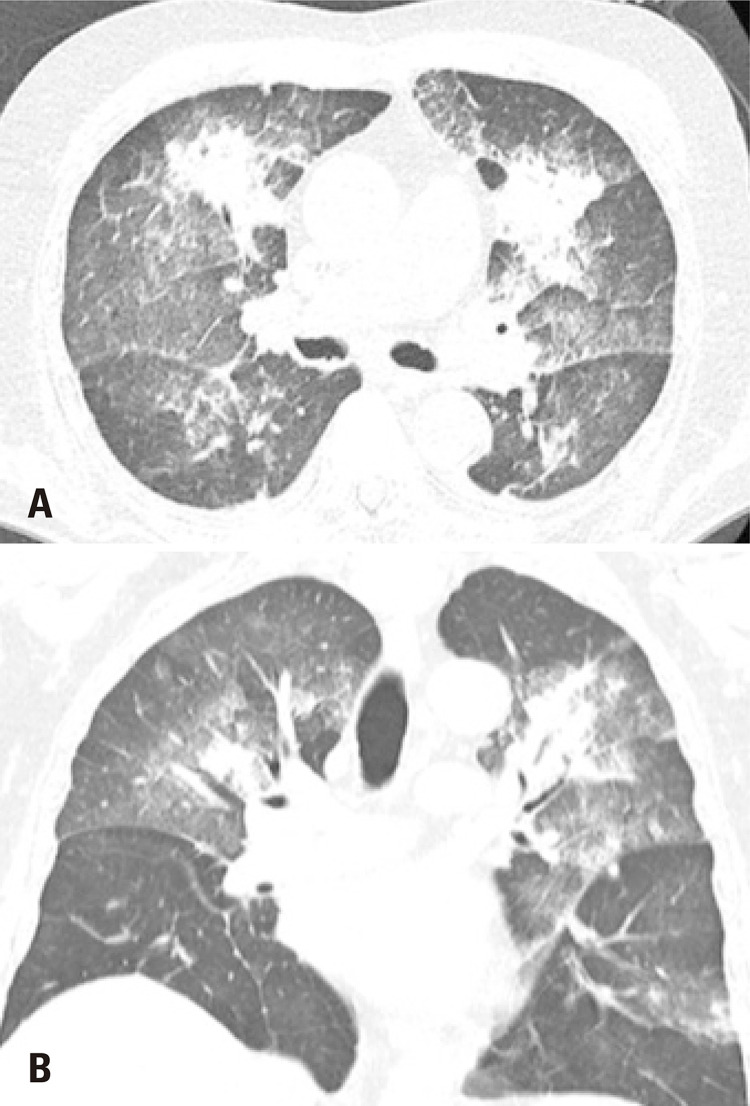
Homem, 65 anos, com quadro de dispneia. Tomografia computadorizada com plano de corte (A) Axial (B) Coronal: opacidades em vidro fosco confluentes e áreas de consolidação alveolar distribuídas de forma relativamente simétrica na região central de ambos os pulmões, associadas a espessamento septal liso difuso e pequeno derrame pleural bilateral, predominando à direita. Tais achados são sugestivos de edema pulmonar